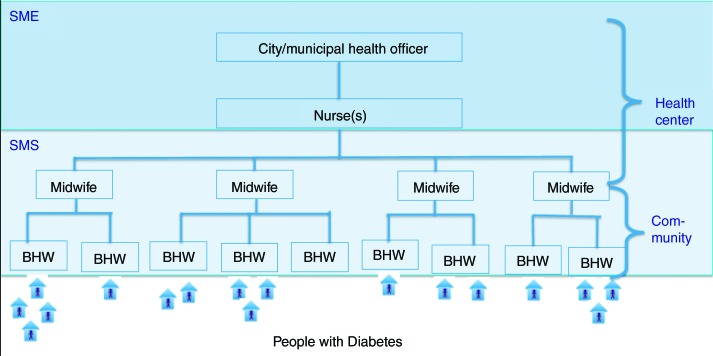
Self-management education and support strategy utilizing pre-existing local government unit healthcare workers in their present organization.